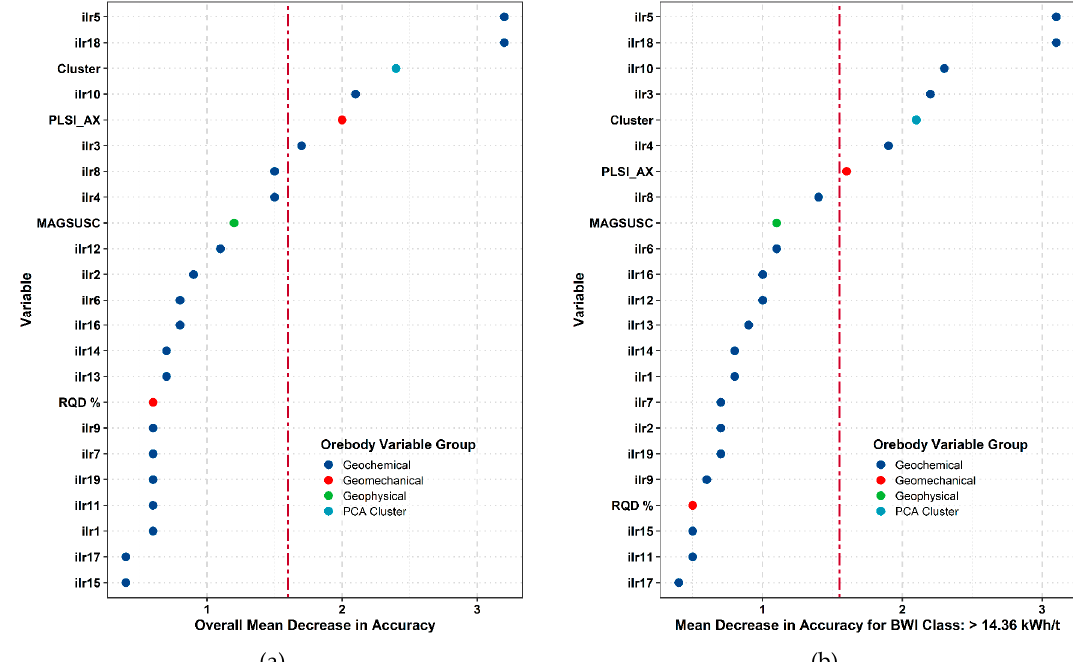
Figure 19. RF variable importance plots for ( a ) Overall classification and ( b ) >14.36 kWh/t class. Variables are ranked in descending order of importance. The horizontal axis is in percentage decrease in out-of-bag (OOB) classification accuracy after permutation of variables. Red dashed line indicates 50% of the most important variable’s decrease in accuracy. The type of each orebody variable is color coded.